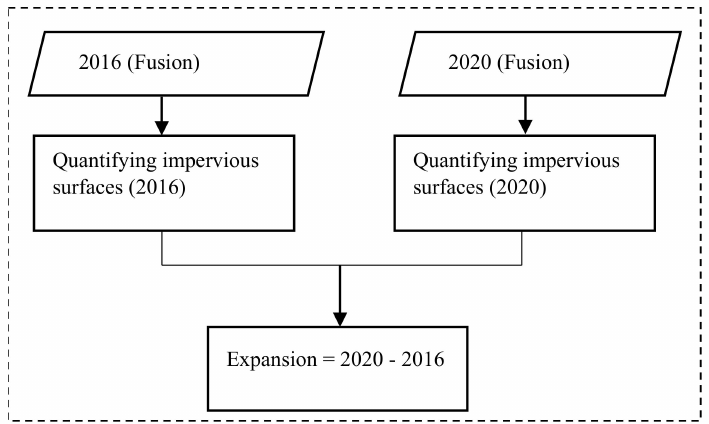
Figure 3. Flowchart for quantification of expansion of the cities from classified maps obtained from fused